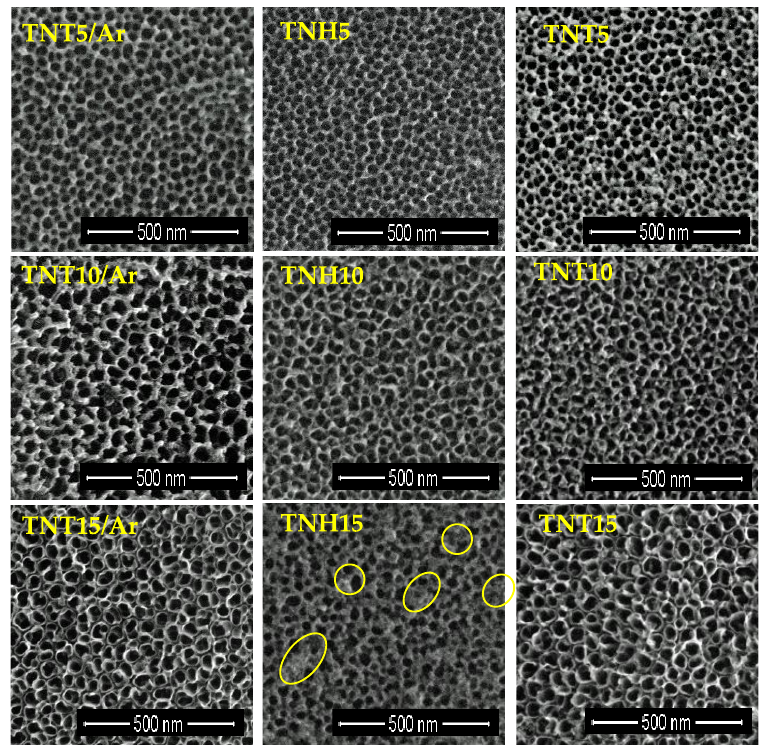
Figure 1. Scanning Electron Microscopy (SEM) images of Ti6Al4V/TNT5-15/Ar, Ti6Al4V/TNH5-TNH15, and Ti6Al4V/TNT5-15 samples surface (selected destruction sites of TiO 2 nanotubes were marked with circles).